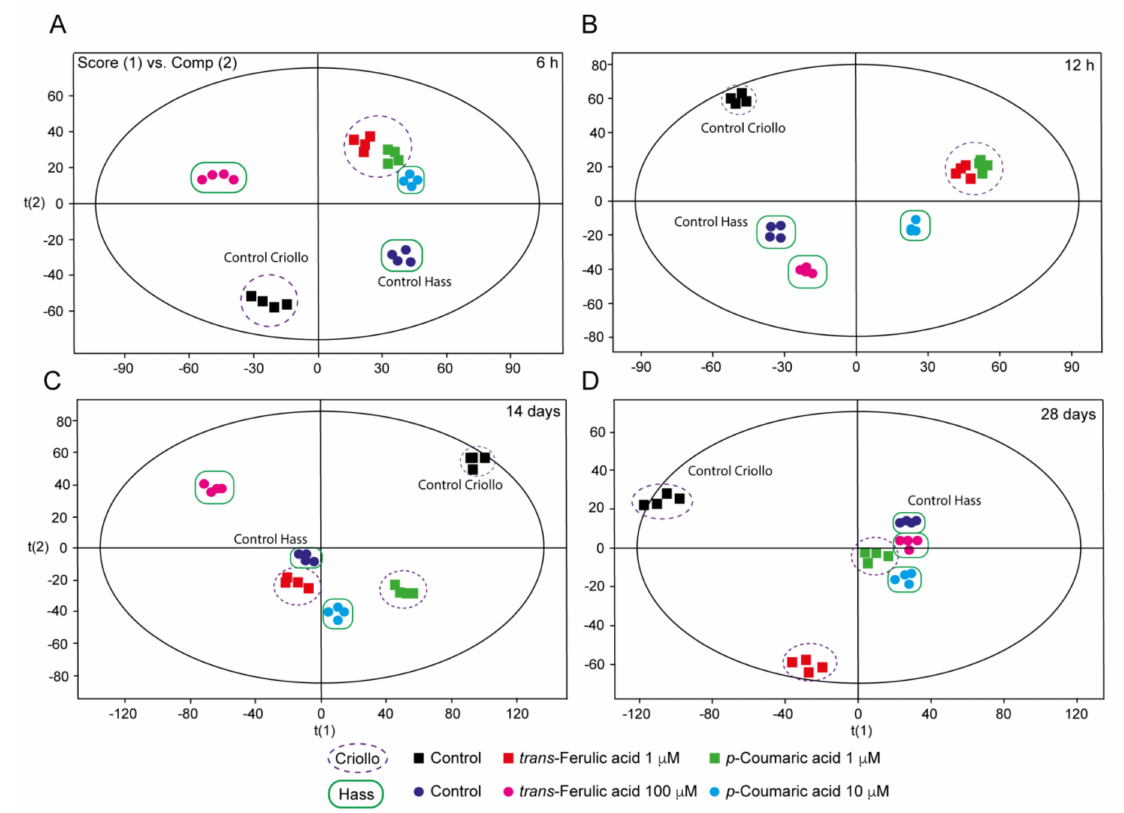
Figure 4. Principal component analysis (PCA)-mediated grouping of Criollo and Hass EC treated with p -coumaric acid and trans -ferulic acid over 6 h ( A ), 12 h ( B ), 14 days ( C ) and 28 days ( D ). We used the exact mass spectrum fingerprints to carry out the principal component